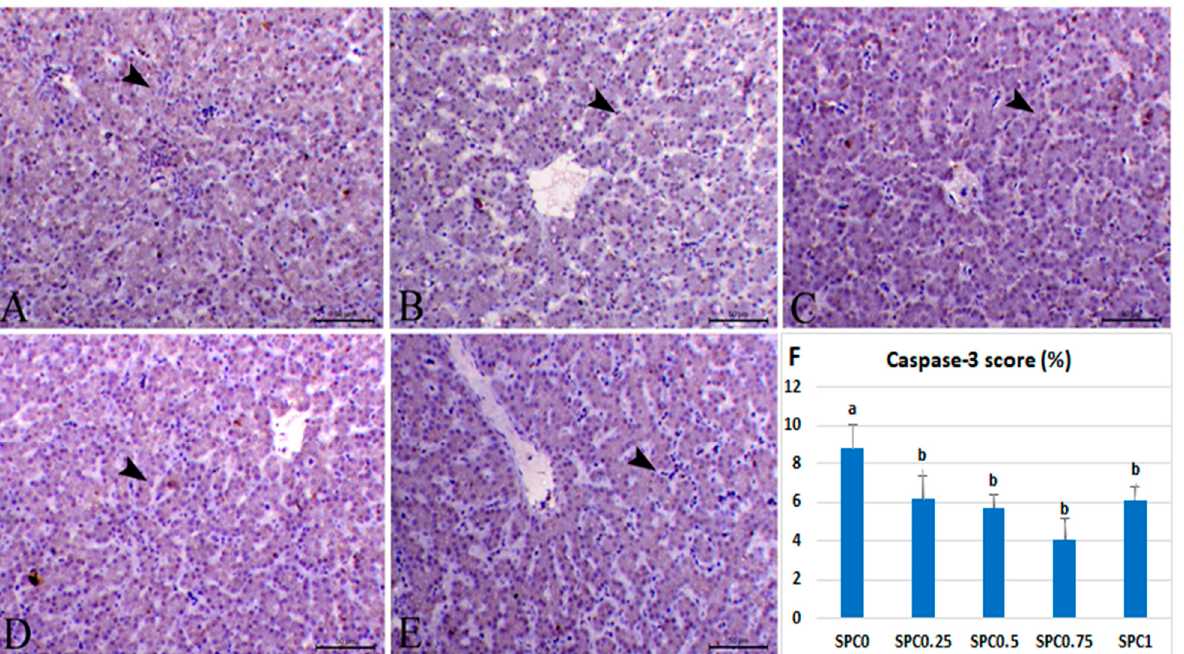
Figure 4. Photomicrograph of hepatic tissues immunostained with TNF- α antibody. The liver of the control SPC0 group showed mild expression of TNF- α within a few hepatocytes ( A ) (arrowhead). The liver of the SPC0.25 group showed scanty expression of TNF- α within hepatocytes ( B ) (arrow- heads). The liver of the SPC0.5 group showed a marked decrease in immunostaining of TNF- α within hepatic tissues ( C ) (arrowhead). The liver of the SPC0.75 showed a significant decrease in the